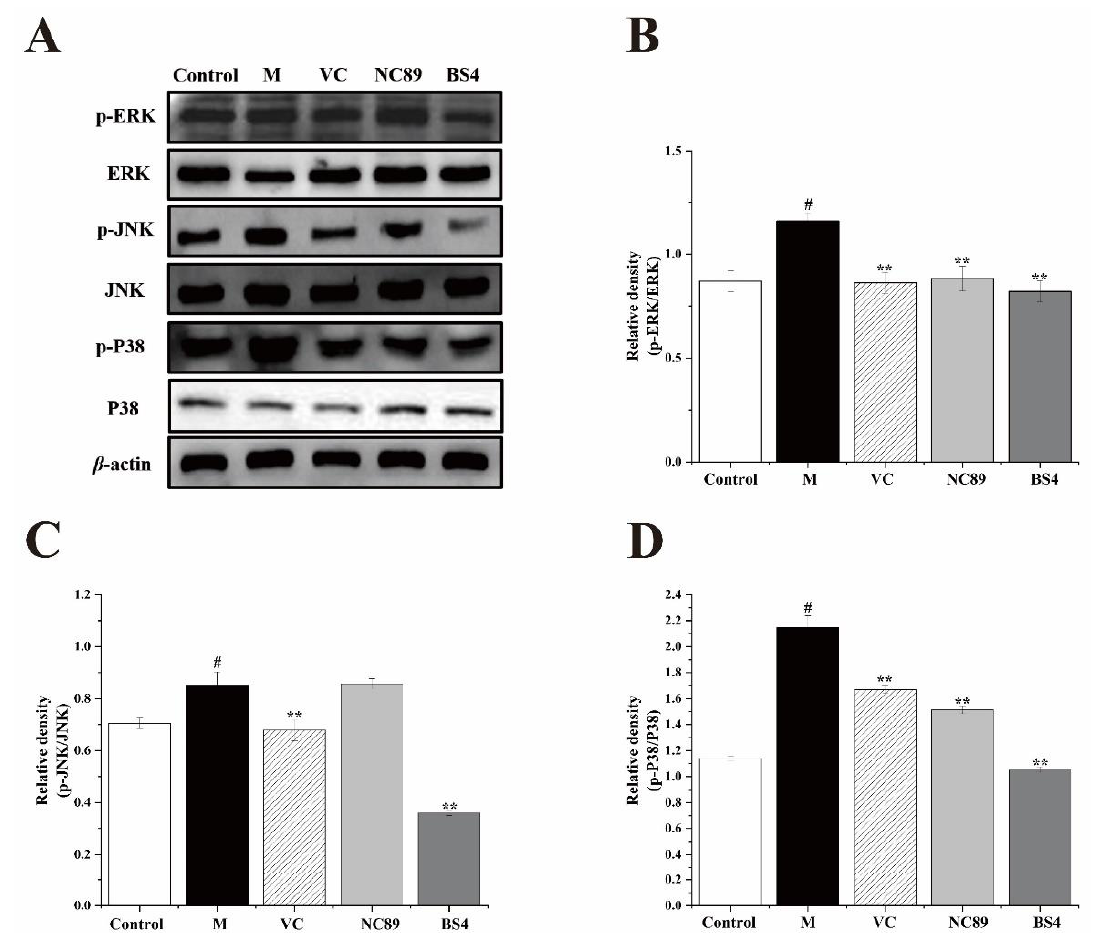
Figure 7. NC89- and BS4-mitigated LPS-induced inflammatory response via the MAPK signal pathway. ( A ) The protein expression of MAPK pathway was determined by Western blotting. ( B – D ) The quantification of ERK, JNK, and P38 protein expression was performed by Image J. The values are presented as mean ± SD ( n = 3). # p < 0.05, vs. the Control group; ** p < 0.01, vs. Model group.